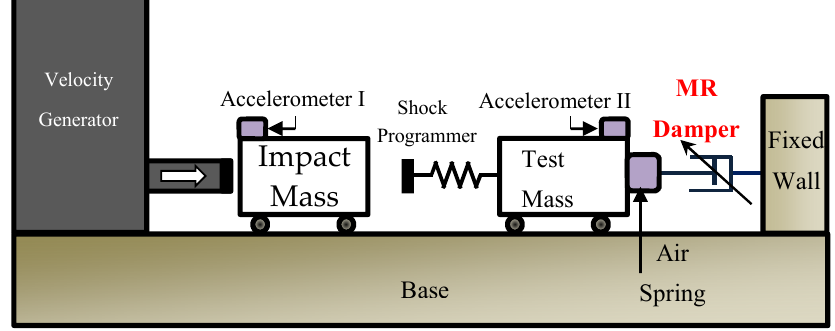
Figure 3. Schematic diagram of the horizontal hydraulic double pulse shock test setup.